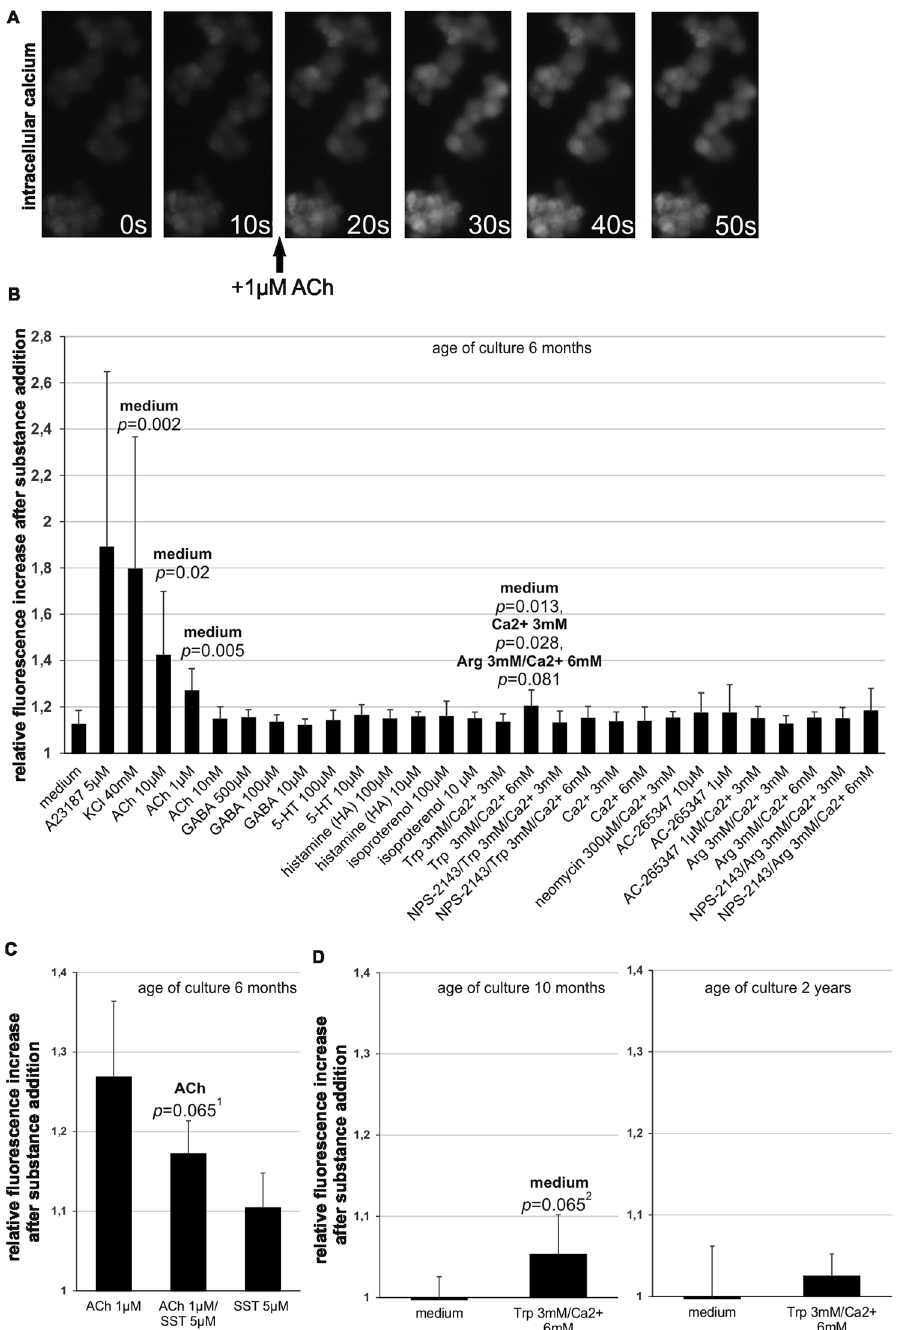
Figure 2. Intracellular [Ca 2 + ] i response of P-STS to addition of neurotransmitters and CaSR ligands. ( A ) Time course of intracellular fluorescence of a group of Fluo-4 AM-stained P-STS cells after treatment with 1 µ M ACh. ( B ) Screening experiment (see explanation in Methods ) for fluorescence enhancement measured 10 s after the start of substance addition in relation to baseline fluorescence. Final substance concentrations are indicated. NPS-2143 (final concentration 2 µ M) was added 1 min before taking the first time point for baseline determination. Mean values and standard deviations were calculated from 3–15 independent samples. Statistical significance compared to the treatment group indicated on top of the bar was calculated by univariate analysis with the Mann-Whitney U -test. ( C ) Inhibition of ACh-induced P-STS activation by somatostatin. Mean values and standard deviations were calculated from 6 experiments. 1 p = 0.059 when calculated from ranked data by the unpaired two-tailed t -test assuming unequal variances. ( D ) [Ca 2 + ] i response to 3 mM Trp/6 mM Ca 2 + after 10 months and 2 years of continuous cultivation. Mean values and standard deviations were calculated from 6 experiments. 2 p = 0.049 when calculated from ranked data by the unpaired two-tailed t -test assuming unequal